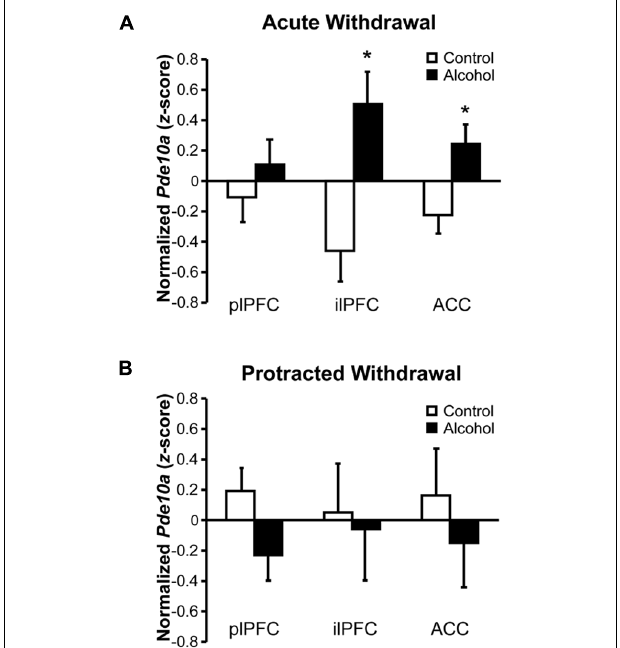
FIGURE 1 |Acute and protracted alcohol withdrawal differentially impacted Pde10a mRNA expression in the medial prefrontal cortex. (A) Acute (8–10 h) withdrawal from intermittent alcohol vapor (black bars) exposure significantly increased Pde10a mRNA levels in the infralimbic (ilPFC) and anterior cingulate (ACC), but not prelimbic (plPFC), subdivisions of the medial prefrontal cortex, relative to alcohol-naïve control rats (white bars). (B) During protracted withdrawal, 6 weeks after the last alcohol vapor exposure, Pde10a mRNA expression tended to be decreased in the plPFC but was not significantly altered in the ilPFC or ACC. Data are presented as least squares means ± standard error of z -score transformed Pde10a covaried for Cyp expression levels. * p < 0.05 vs. Control; n = 9–12 per